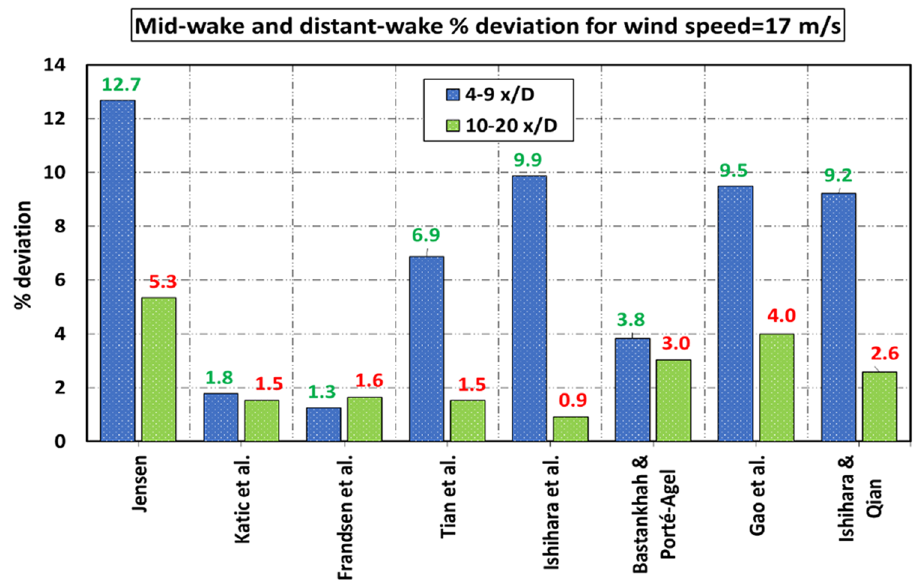
Fig. 11. Average percentage deviation of each wake model for upstream wind speed value equal to